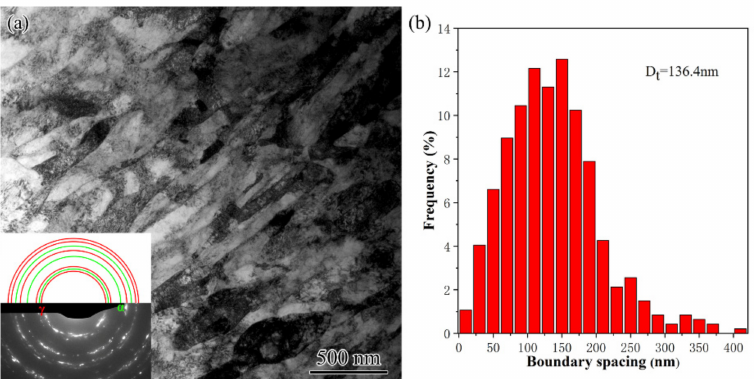
Figure 10. TEM observation ( a ) and the corresponding histogram of boundary spacing ( b ) of the ultrafine lamellae in USRT AISI 304 stainless steel sample. The SAED pattern together with theoretic circles for fcc γ and bcc α was inserted.